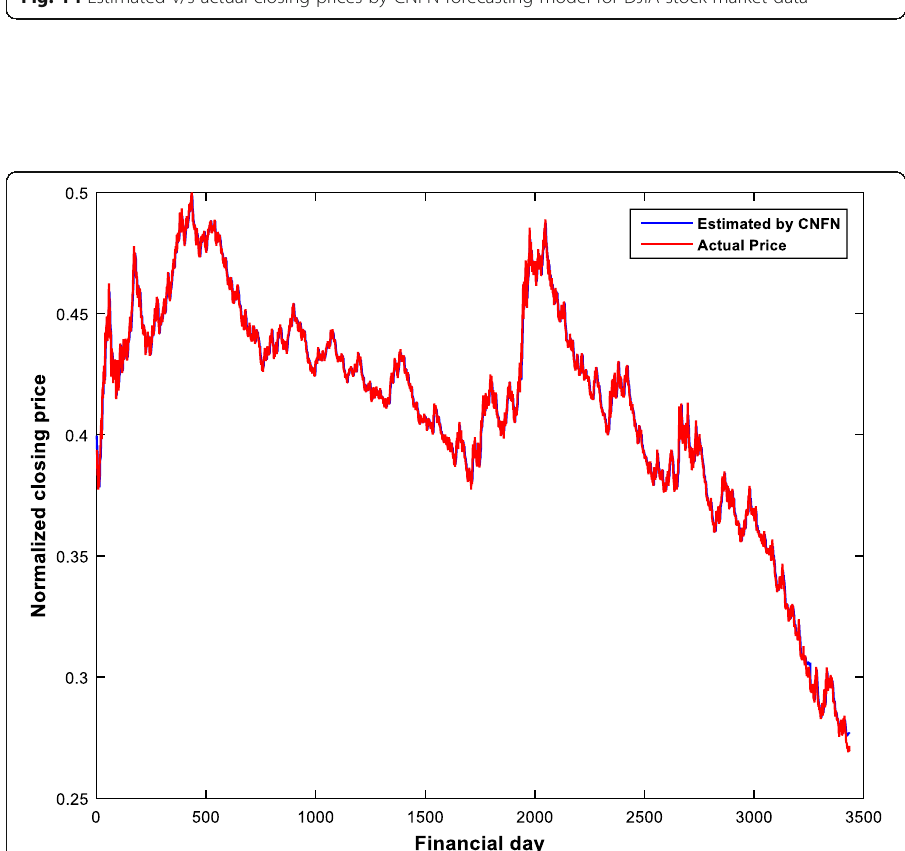
Fig. 15 Estimated v/s actual closing prices by CNFN forecasting model for NASDAQ stock market